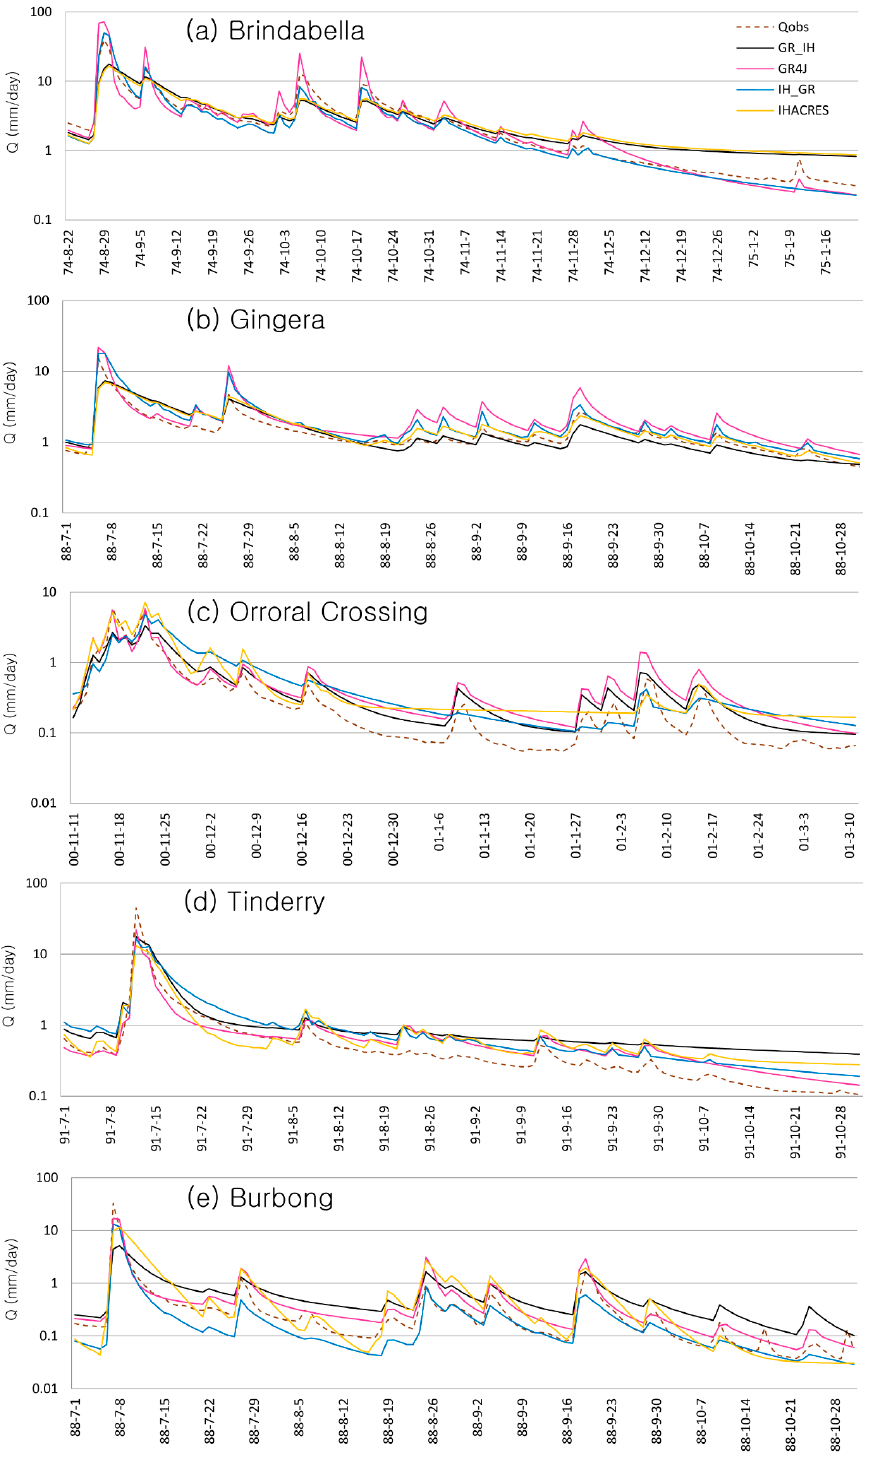
Figure 4. Comparison of the hydrographs of the four rainfall–runoff models for the maximum events with respect to the NSElog objective function: ( a ) validation of the 1970s with the calibration of the 2000s for the Brindabella (wet) catchment, ( b ) validation of the 1980s with the calibration of the 1970s for the Gingera (wet) catchment, ( c ) validation of the 2000s with the calibration of the 1980s for the Orroral Crossing (intermediate) catchment, ( d ) validation of the 1990s with the calibration of the 1970s for the Tinderry (dry) catchment, and ( e ) validation of the 1980s with the calibration of the 1990s for the Burbong (dry) catchment.